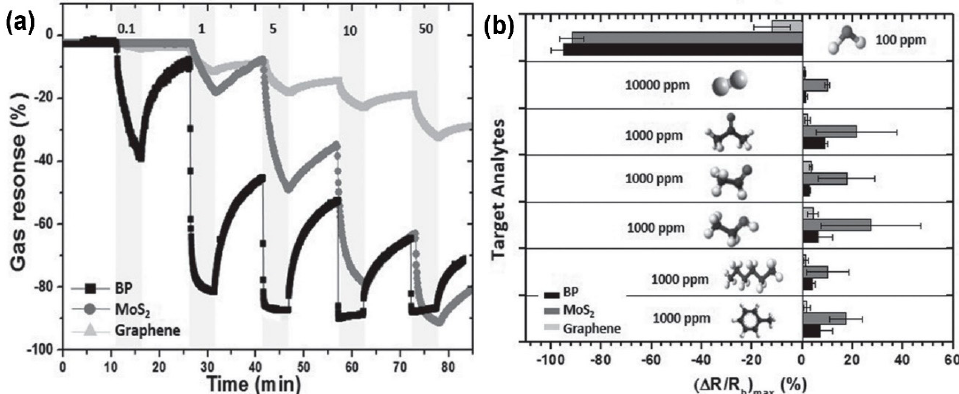
Figure 24. Panel ( a ): resistance variation of BP, MoS 2 and graphene sensors exposed to 0.1, 1, 5, 10 and 50 ppm of NO 2 ; Panel ( b ): the maximal resistance change onto various analytes of BP, MoS 2 and graphene sensors. (Adapted and reprinted from [213], with permission from Wiley-VCH Verlag GmbH & Co. KGaA, Weinheim, Germany).